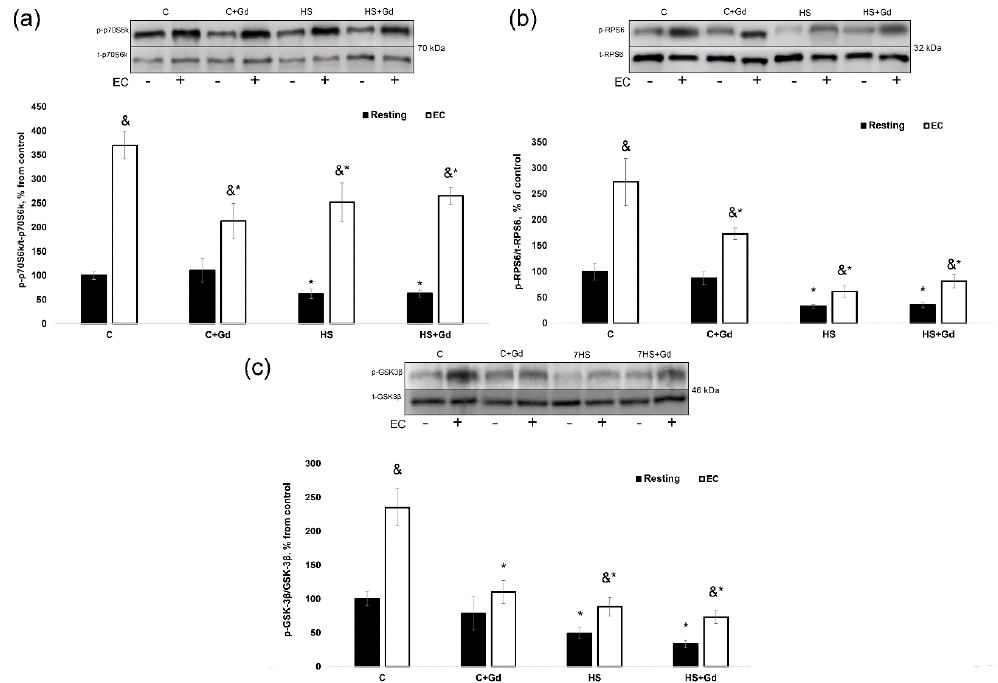
Figure 5. The effect of SAC blockade on the key markers of mTORC1-signaling and GSK-3 β in the